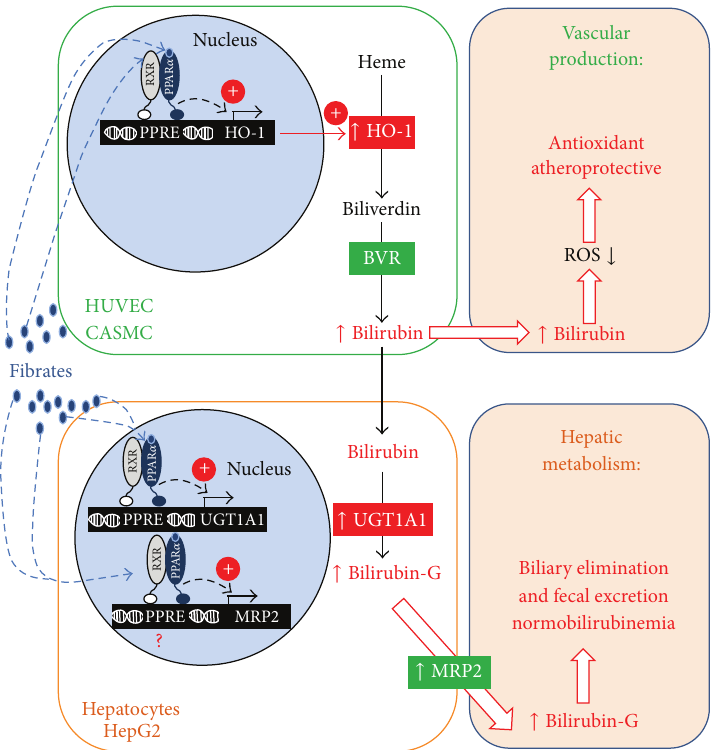
Figure 5: Coordinated regulation of bilirubin synthesis and metabolism by PPAR 𝛼 agonists has antiatherosclerotic effects in the vasculature and normobilirubinemic consequences in the liver. Results presented here suggest that PPAR 𝛼 agonists, such as fenofibrate, gemfibrozil, and Wy14,643, activate the synthesis of bilirubin in the vasculature and its elimination in the liver. In vascular cells (HUVEC and CASMC), fibrates activatePPAR 𝛼 ,whichinturnbindstoPPREslocatedinthepromoterregionofthe HO-1 gene[20].ThisleadstoanincreasedHO-1expression and heme-to-bilirubin conversion. As a potent antioxidant, bilirubin scavenges reactive oxygen species, and by so exerts atheroprotective effects. In liver cells (hepatocytes), fibrates also activate PPAR 𝛼 , which in turn binds to PPREs located in the promoter region of the UGT1A1 [25] and potentially MRP2 genes (this remains to be established). These regulatory events lead to increased bilirubin-glucuronide production and biliary secretion and by so contribute to reduce systemic accumulation of bilirubin. BVR: biliverdin reductase; CASMC: coronary